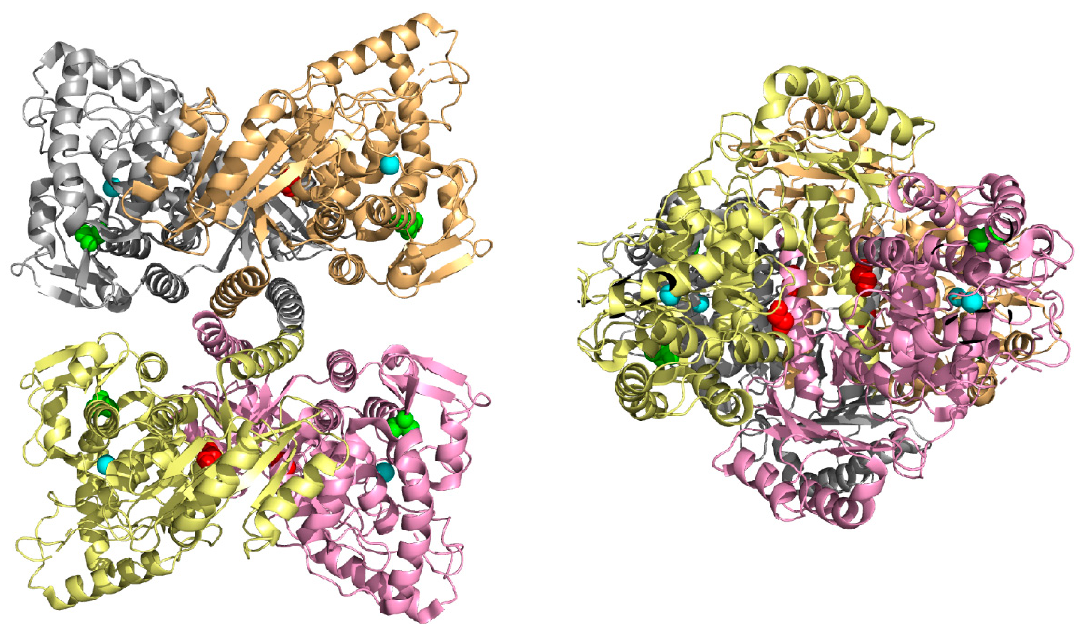
Figure 1. Top view (left) and side view (right) on the X-ray tetrameric rat PAH structure with color monomers. Gly239 is highlighted in sphere representation in red, Ala342 is in green, and Fe ion in the active site is in cyan.